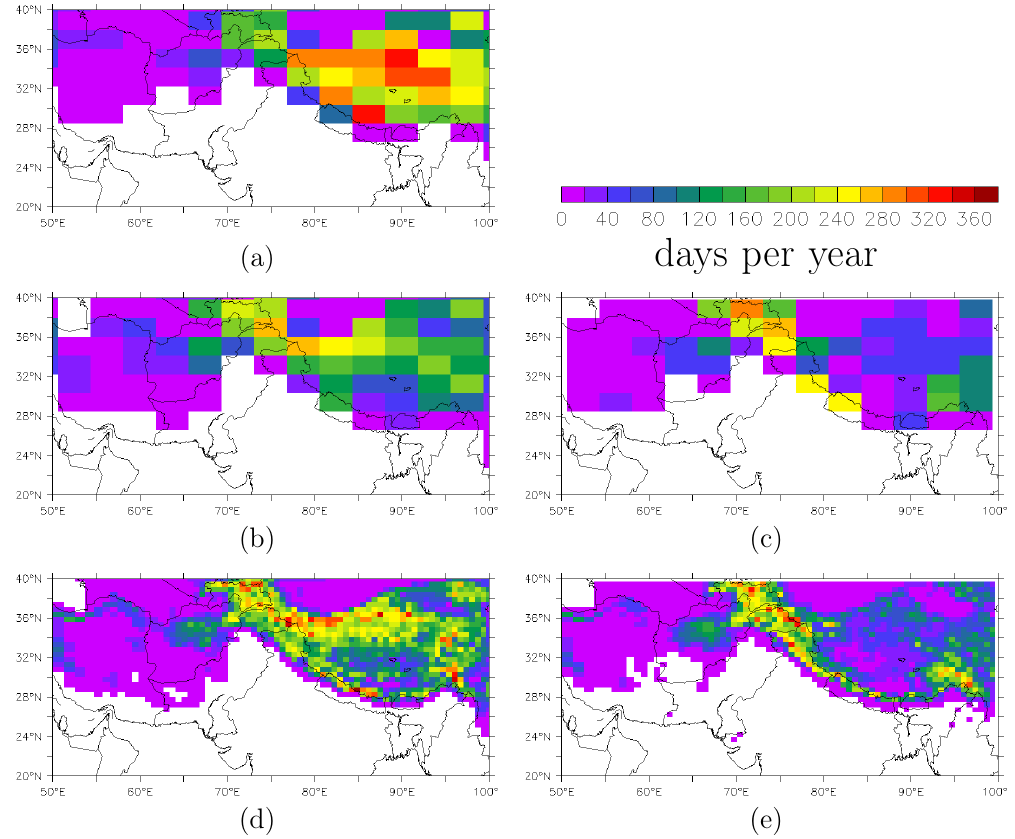
Fig. 1. Annual mean snow cover duration (days per year) averaged over 1998–2008: (a) LMDZ coarse-gridded simulation ( ∼ 350km). (b) LMDZ simulation based on a stretched grid ( ∼ 50km) interpolated on the coarse grid of LMDZ. (c) Satellite observation interpolated on the coarse grid of LMDZ. (d) LMDZ simulation based on a stretched grid ( ∼ 50km). (e) Satellite observation interpolated on the LMDZ stretched grid. LMDZ simulations were performed with the BC effect on snow albedo. IMS satellite observations are from NSIDC